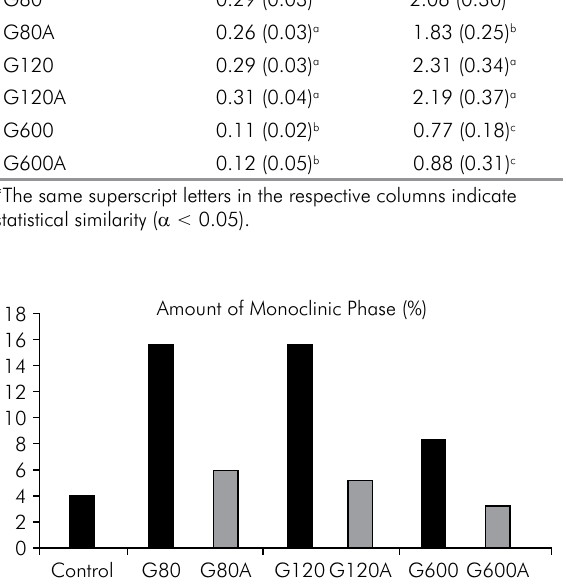
Figure 2. Relative amount of monoclinic phase, according to X-ray diffraction analysis in each tested group: CG (4.15%), G80 (15.64%), G80A (5.97%), G120 (15.6%), G120A (5.24%), G600 (8.39%), G600A (3.27%).